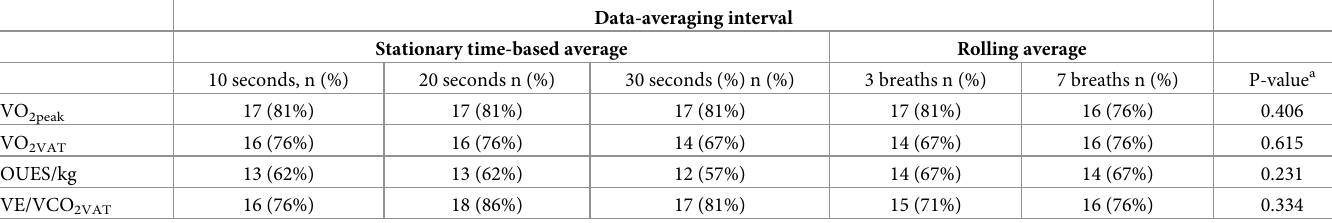
Table 3. Effect of different data-averaging intervals on classifying patients as having a high-risk for postoperative